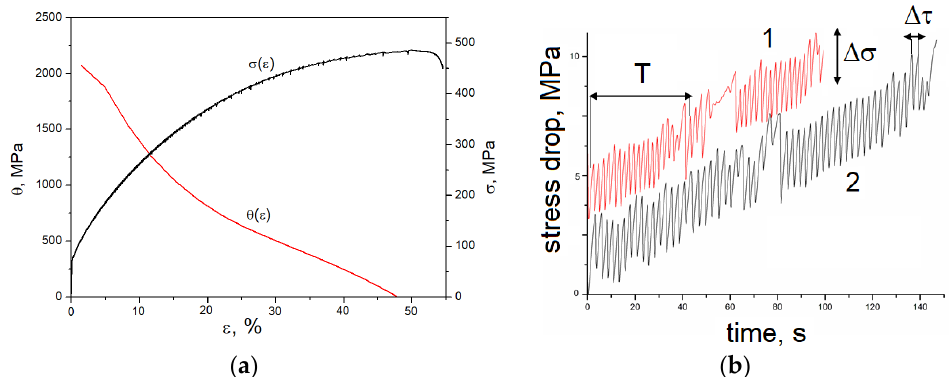
Figure 2. Stress–strain curve σ ( ε ) and work-hardening coefficient θ ( ε ) of Ni samples ( a ); example of stress drop as a function of time for Sections 1 and 2 ( b ). The numbers of sections correspond to those from Figure 1a.